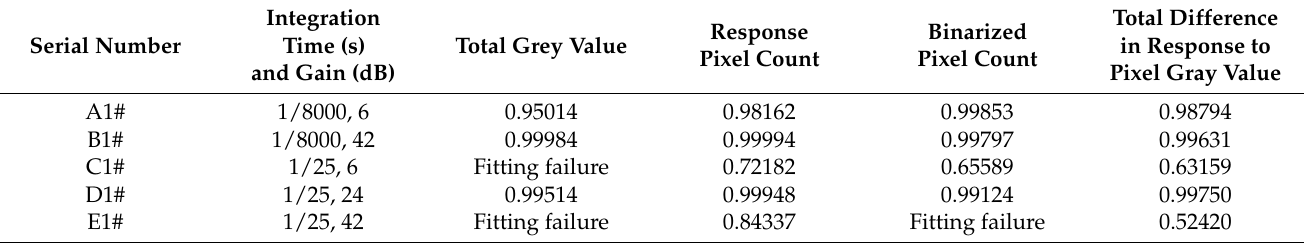
Table 5. Error analysis of global eigenvalue fitting results of color images.